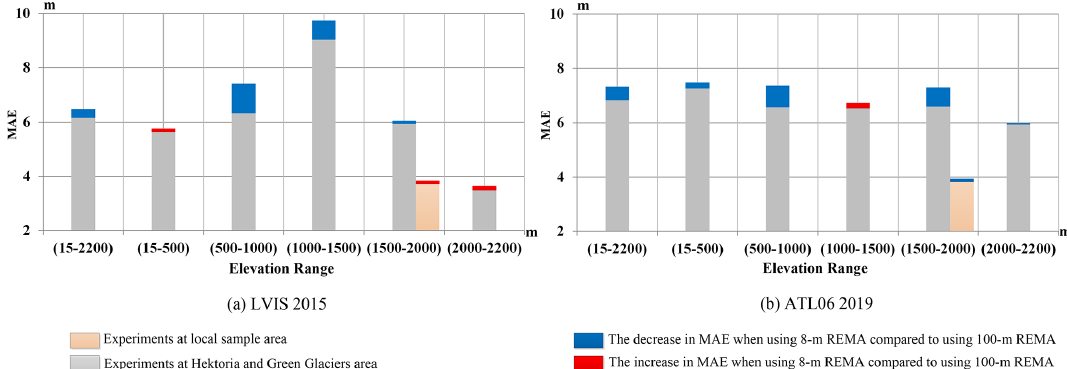
Figure 13. Changes in MAE of the corrected TDM DEM when using the 8 and 100m REMA mosaic as ground reference. Results were evaluated against (a) LVIS 2015 and (b) ATL06 2019